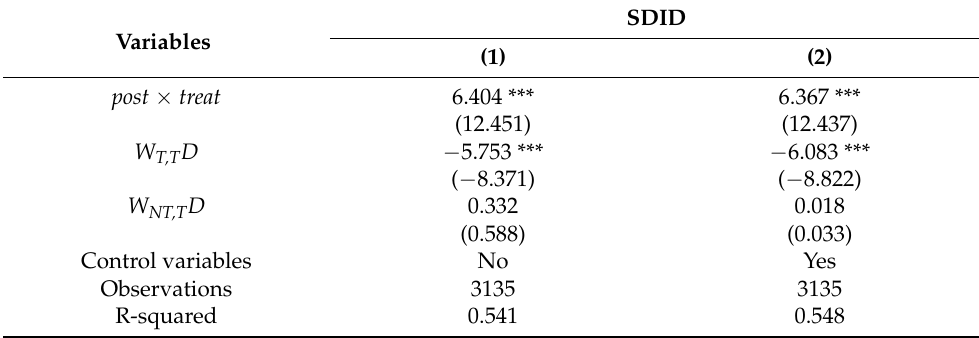
Table 5. Parameter estimation results of the SDID model.